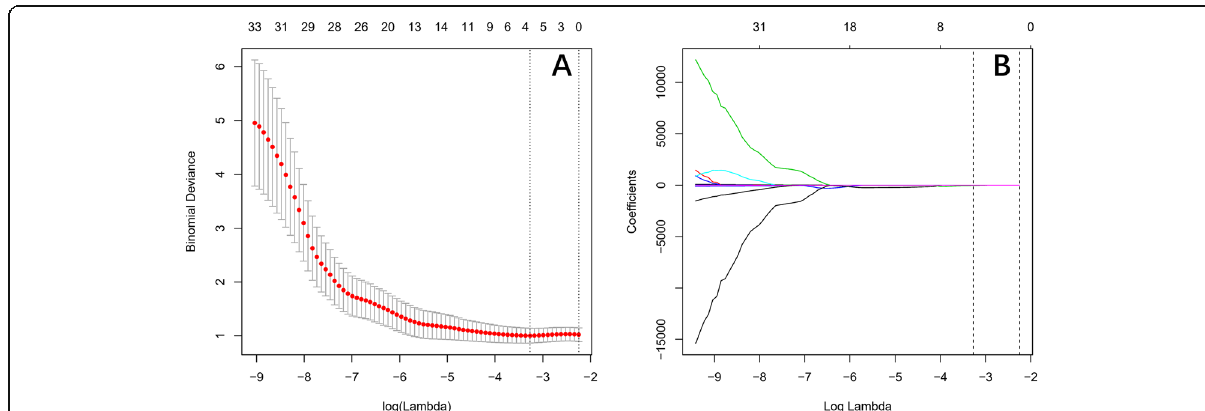
Fig. 2 The best subset of radiomic features was extracted using the LASSO algorithm and 10-folds cross-validation. a The best feature was selected based on the AUC value. The black vertical line defines the best value of λ , and the model provides the best fit of the data. λ = 0.038 with log ( λ ) = − 3.2697 is selected as the optimal value. b The LASSO coefficient profiles of 38 radiomic features. The vertical line is the value selected by 10-fold cross-validation in a , where the best λ results in four nonzero coefficients of four selected